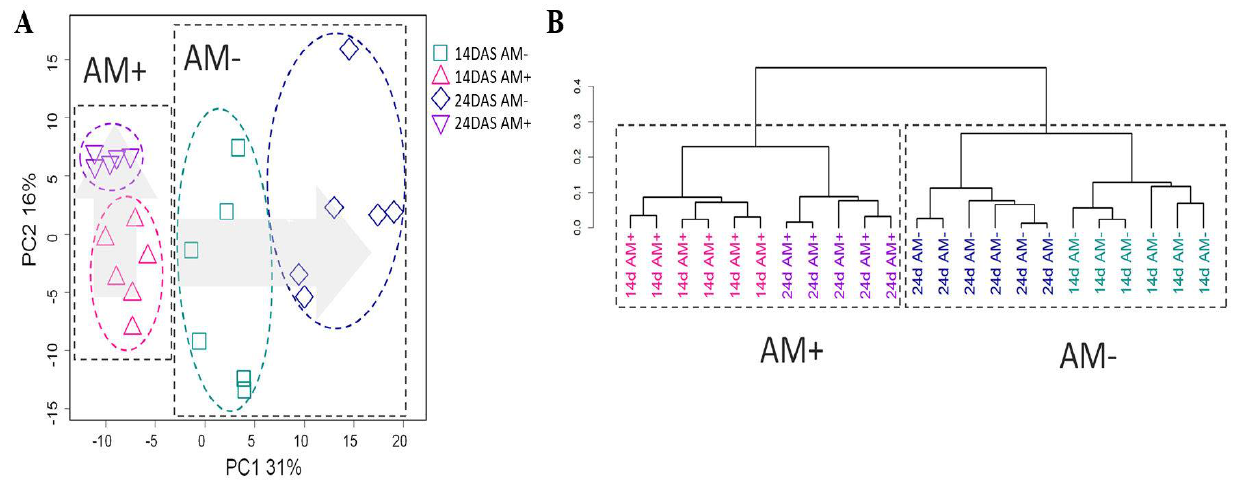
Figure 2. Unsupervised analysis of metabolite profiles of mycorrhized (AM+) and non-mycorrhized (AM − ) roots of Medicago lupulina plants sampled at 14 and 24 days after sowing. PCA score plot ( A ), dendrogram of hierarchical clustering ( B ).